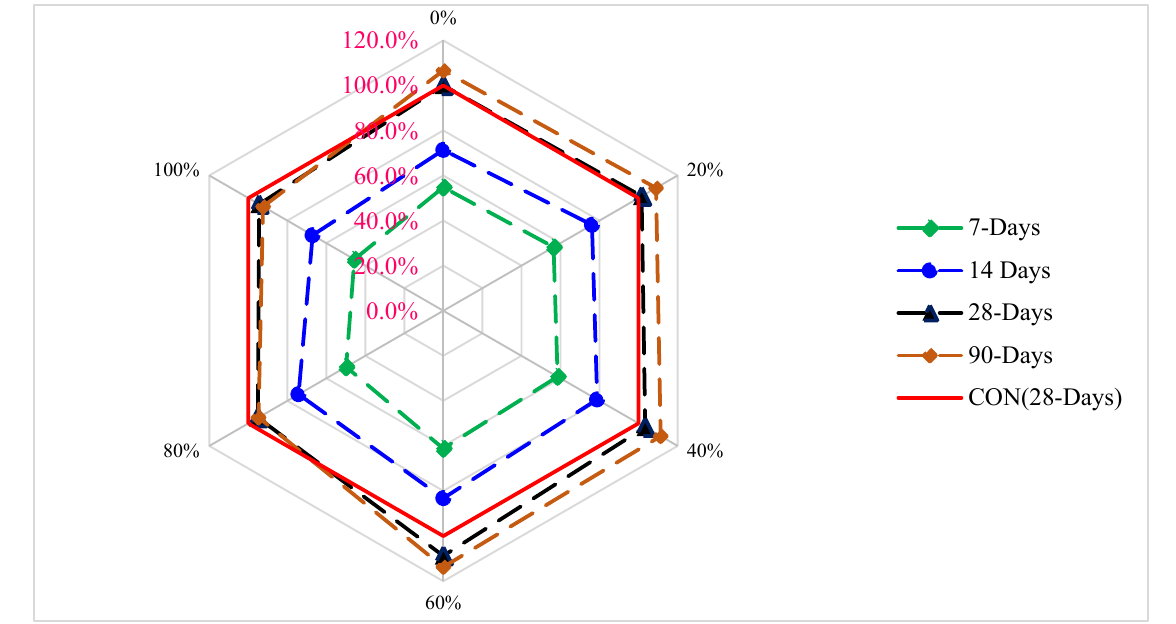
Figure 8. Relative compressive strength of concrete: data source [45].